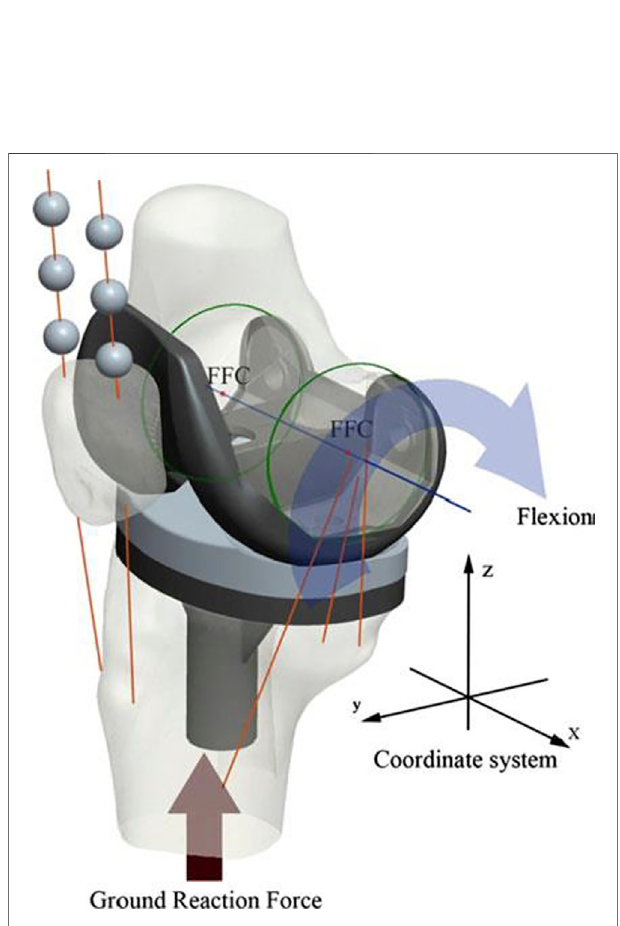
FIGURE 2 | The TKA model and the coordinate system in